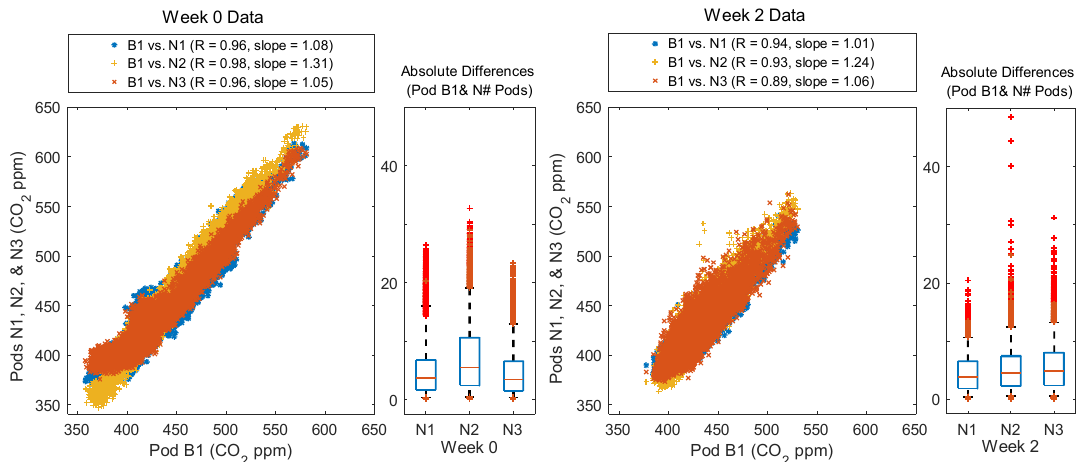
Figure 3. Scatter plots showing each neighborhood Y-Pod (N1, N2, and N3) vs. Y-Pod B1 for Weeks 0